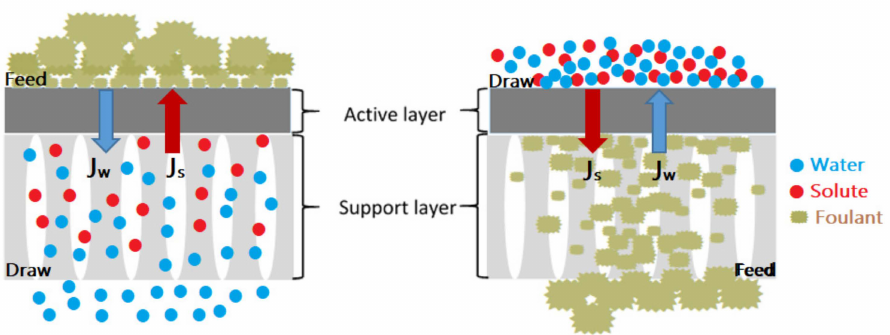
Figure 13. Schematic descriptions of membrane fouling at AL–FS orientation (left-hand side figure) and AL–DS orientation (right-hand side